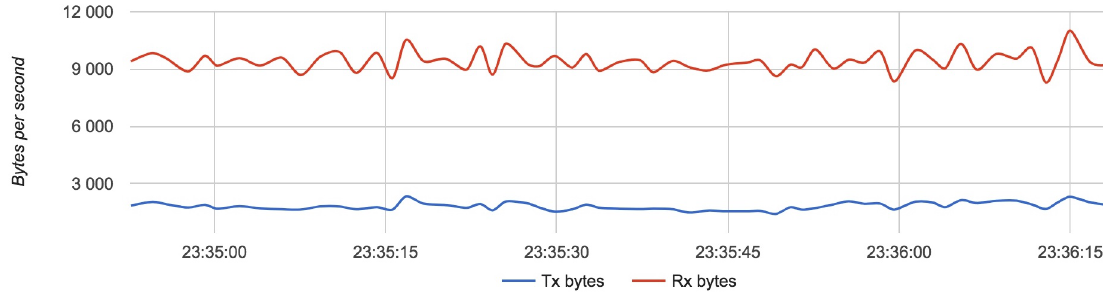
Figure 19. Bandwidth usage for a server with Configuration 1.